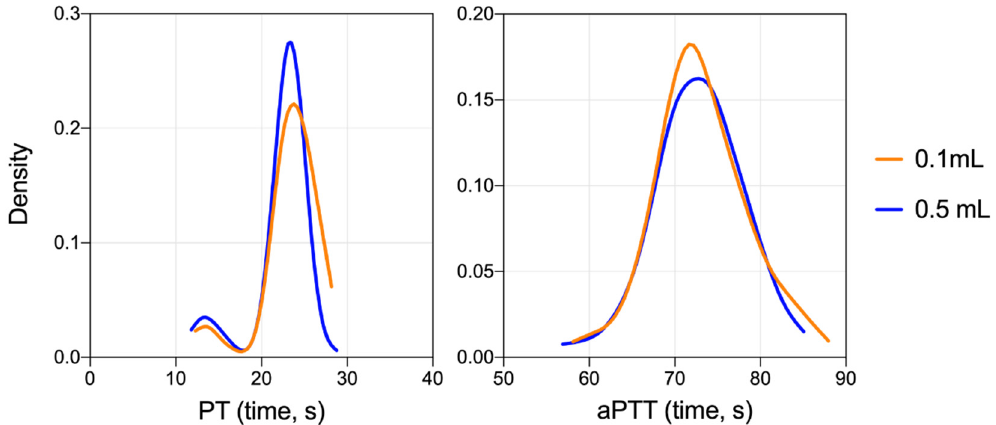
Figure 2. Kernel density estimation for prothrombin time and activated partial thromboplastin time values from 0.1 mL or 0.5 mL samples. Values from both PT and aPTT tests were evaluated using the kernel density estimation (KDE), a non-parametric estimate of the probability density function of a random variable. The KDE demonstrated overlapping distribution between 0.1 mL and 0.5 mL collection volumes for both PT and aPTT.